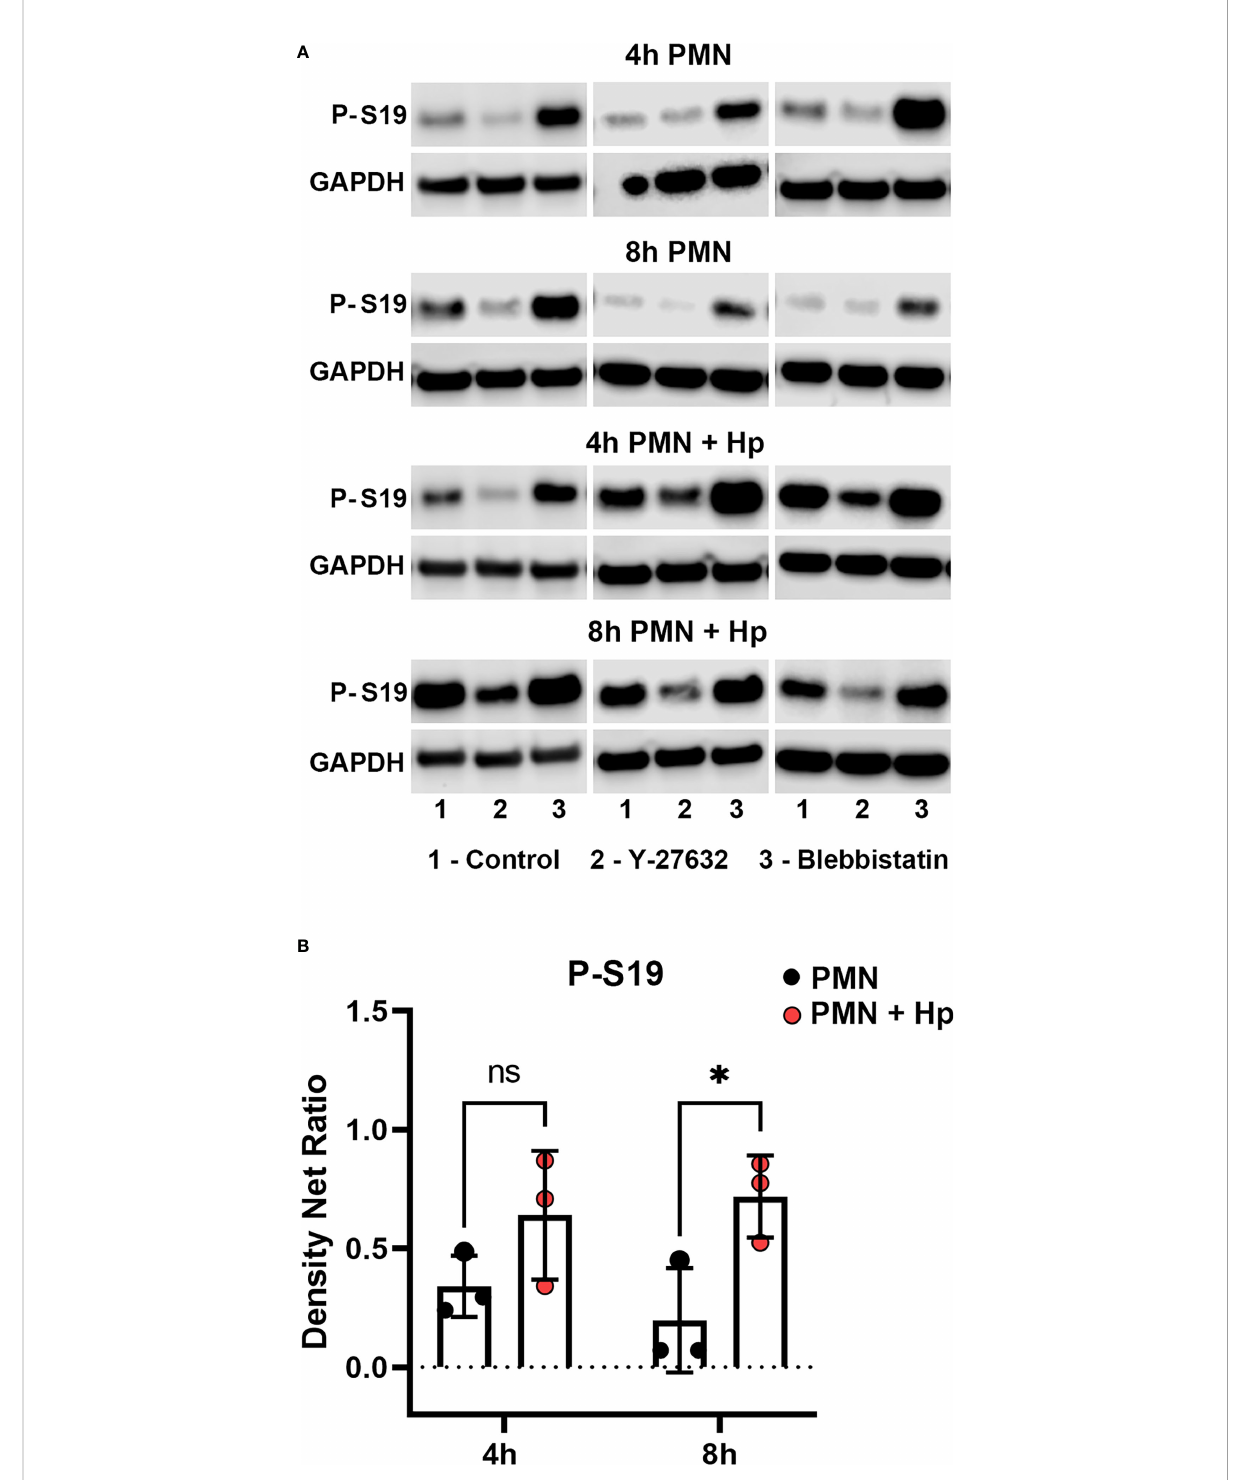
FIGURE 8 Effects of infection, Y-27632 and Blebbistatin on myosin IIA RLC S19 phosphorylation. Neutrophils were left untreated or infected with H . pylori for 4 or 8 hours in the presence and absence of Y-27632 or Blebbistatin, as indicated. Immunoblots of whole cell lysates were probed to detect myosin IIA RLC S19 phosphorylation prior to stripping and reprobing with antibodies to GAPDH as the loading control. (A) Data from three representative experiments. (B) Quantitation of normalized S19 phosphorylation intensity for uninfected and infected PMNs (in absence of drugs) at 4 and 8 h are the mean ± SD (n=3). ns, not signi fi cant. * p <0.05. Additional data analyses are shown in Supplementary Figure